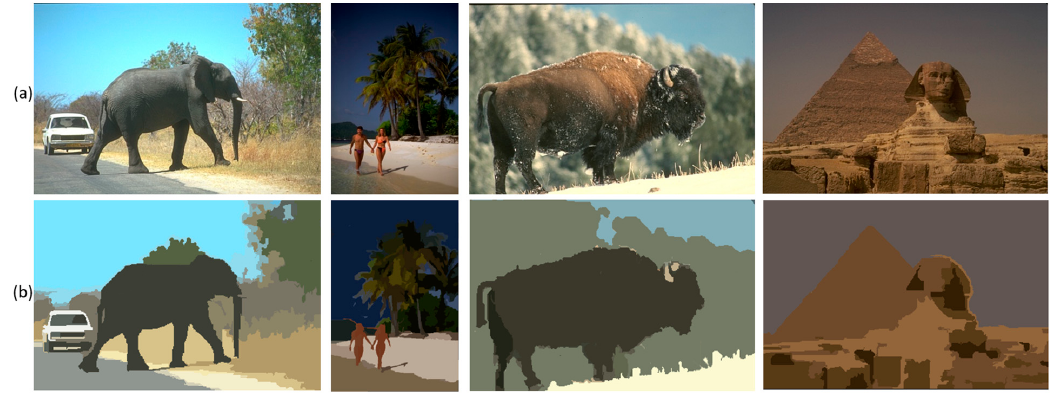
Figure 4. Segmentation results. From top to bottom: ( a ) Original images, ( b ) segmentation results of proposed algorithm.